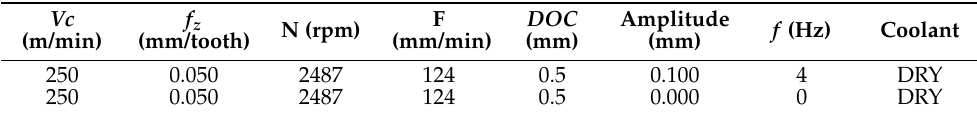
Table 4. LFAB and conventional boring